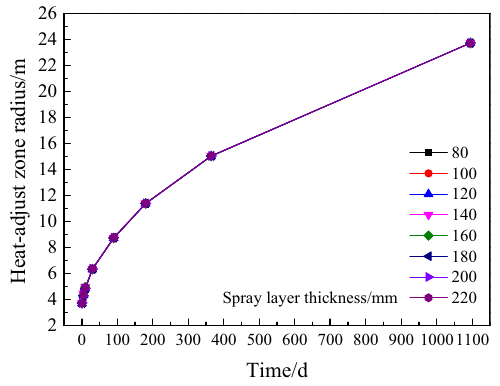
Figure 18: Influence of spray layer thickness on heat - adjusting zone